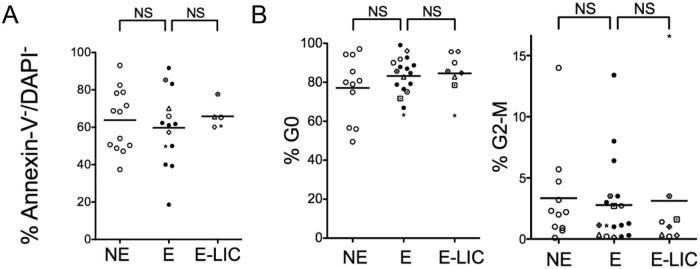
Cell viability or cell cycle profiling at thawing do not account for engraftment defect. (A) Data shown represent the post-thaw AML percent cell viability assessed by DAPI and Annexin V exclusion for Non Engrafter (NE, open symbols), Engrafter (E, closed and single symbols) and Engrafter LIC subpopulation (E-LIC) (n = 13, 14 and 5 samples respectively). (B) Cell-cycle profile determined by Ki67 and DAPI staining for NE, E and E-LIC (n = 11, 18 and 8 samples respectively). Plain lines represent mean levels in each group. A single symbol is used for E and E-LIC matched samples. For few samples the LIC and non-LIC phenotype were first functionally pre-established through xenograft experiments on sorted sub-population based on CD34 and CD38 expression. No significant differences were identified between the different groups in parametric or non-parametric paired or unpaired tests.